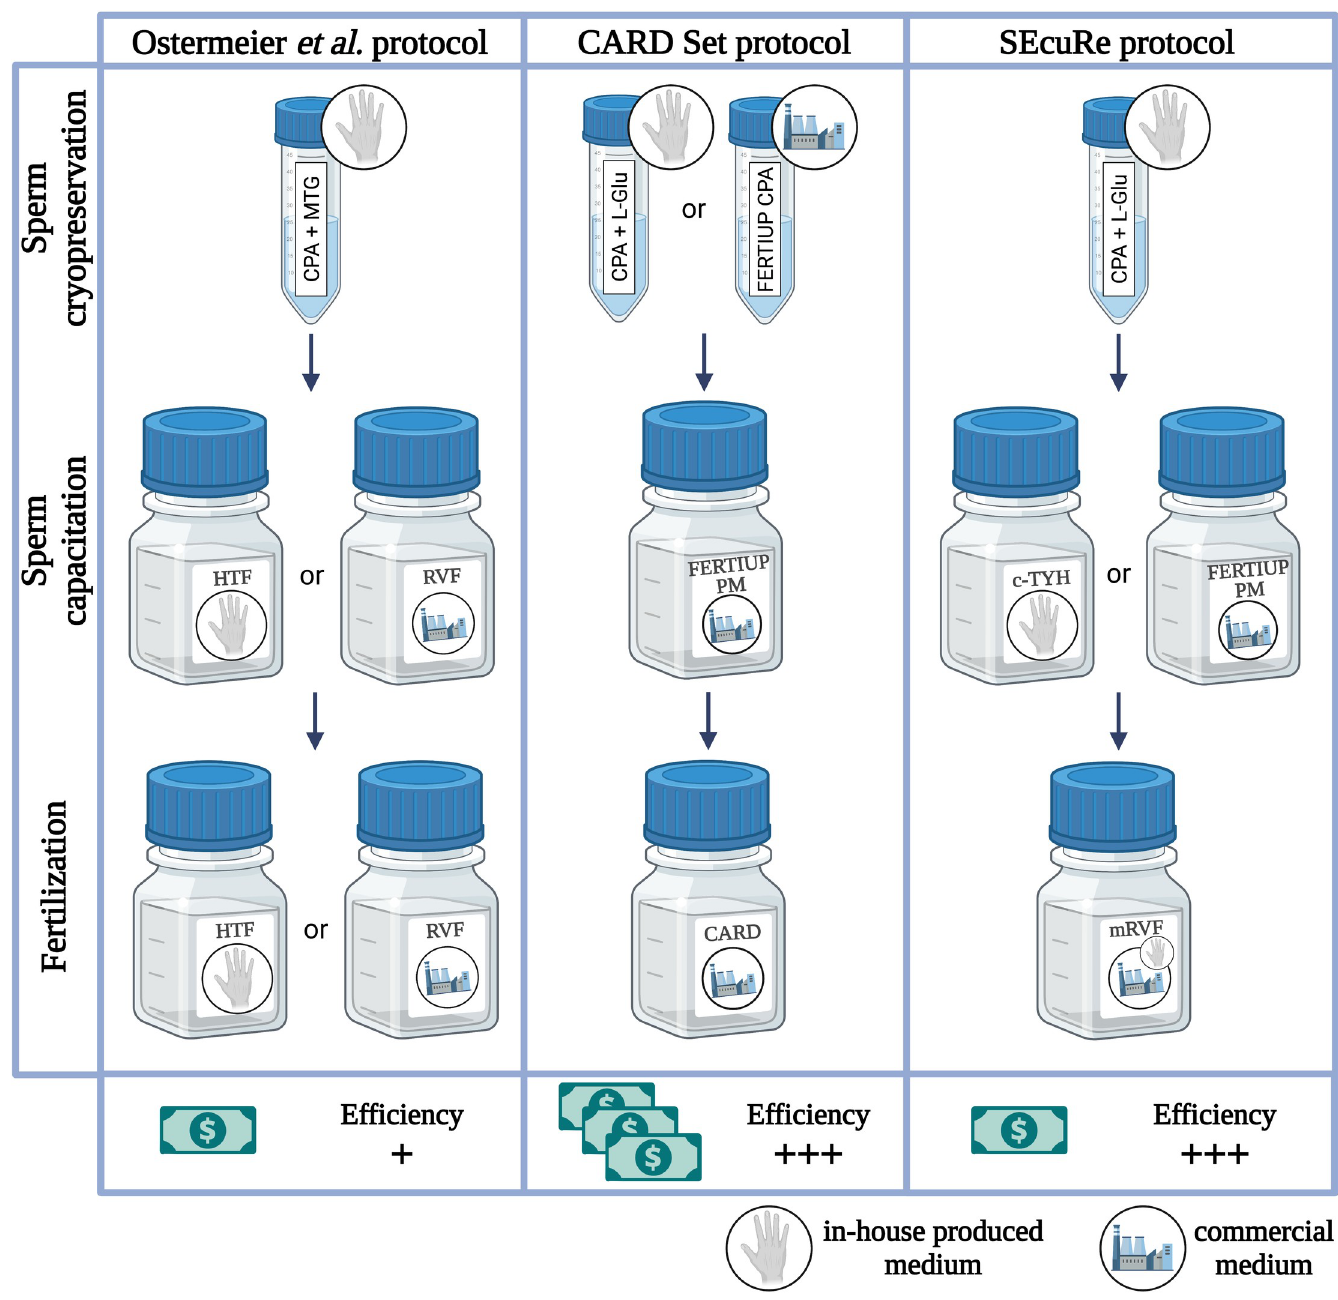
Fig 1. Comparison of the Ostermeier et al ., CARD Set and SEcuRe protocols. CPA = cryoprotective agent; MTG = monothioglycerol; L-Glu = L-glutamine; RVF medium = Research Vitro Fert fertilization medium; mRVF medium = modified RVF fertilization medium with elevated calcium concentration (5.14 mM) and GSH